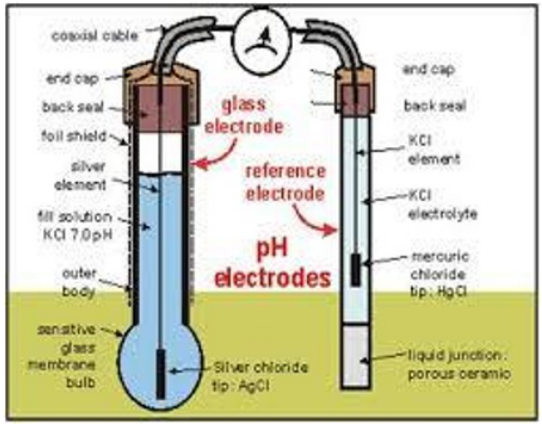
Fig. 10 working of the pH